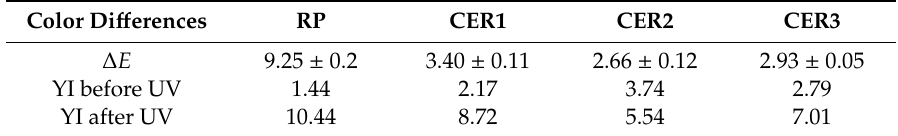
Table 5. UV-aging levels of coatings according to total color di ff erence, ∆ E, and yellowness index, Y1